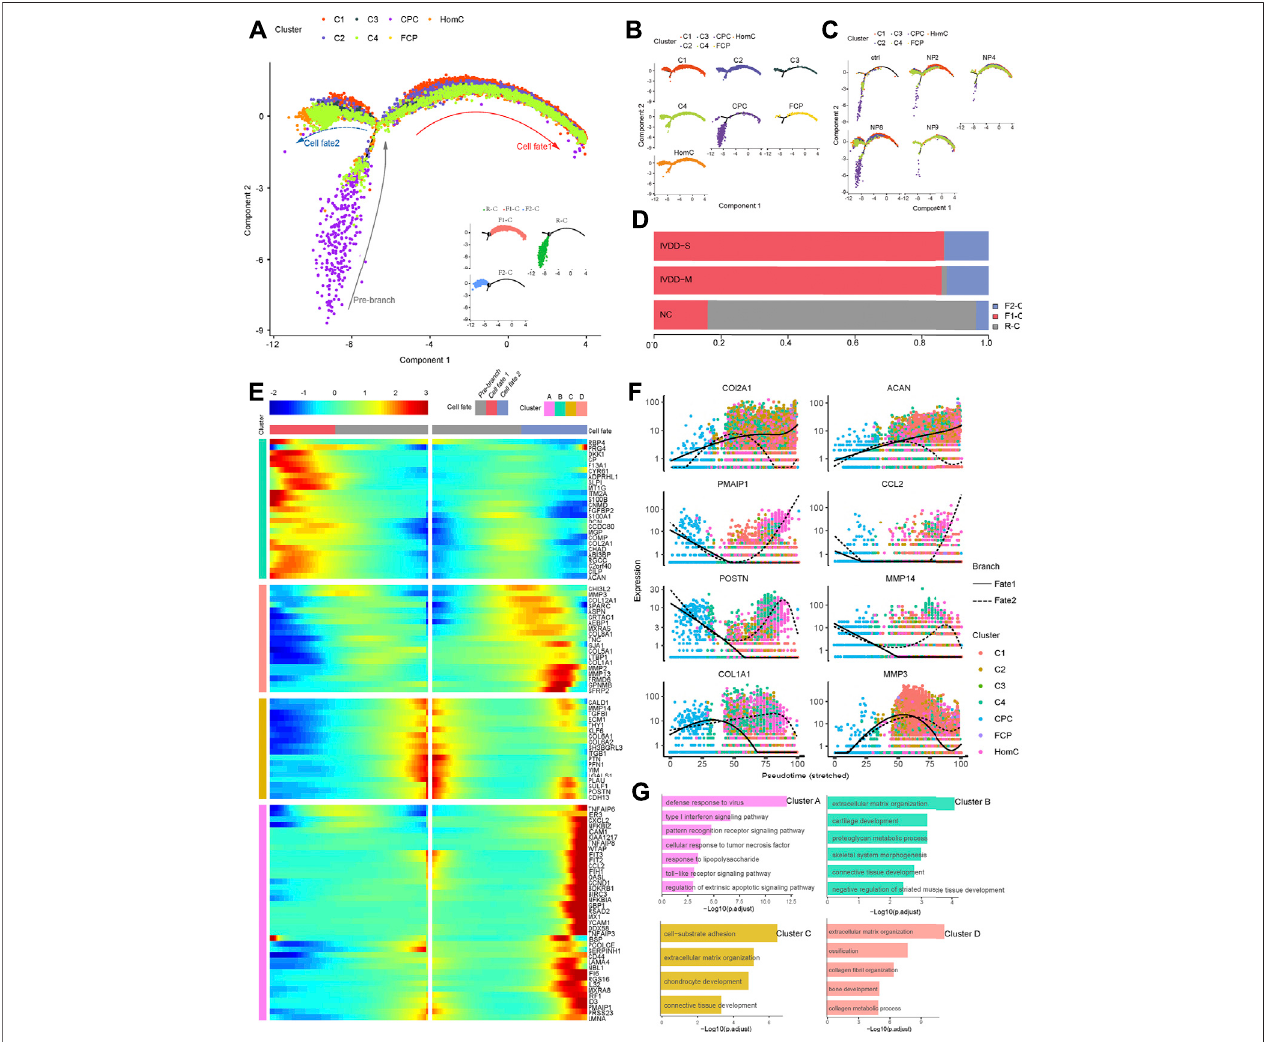
FIGURE 4 | Pseudotime trajectory analysis depicted chondrocyte fate differentiation in IVDD. (A) Monocle two trajectory plot contains three branches and one connecting point showing dynamics of chondrocyte subclusters (except NP10). (B,C) Projection of individual cell types and samples onto the trajectory of (A) . (D) Bar plots represented the proportion of different cell states corresponded to three branches from NC, IVDD-M, and IVDD-S. (E) Heatmap showing the standardized kinetic curvesofthegenesintrajectoryfromroottofate1orfate2. (F) Pseudotimekineticsofspeci fi crepresentativegenesfromtherootofthetrajectorytofate1(solidline) and fate2(dashedline). (G) BarplotsshowingthetopannotatedGOtermsinfourgenessets,whicharehierarchicallyclusteredfrom (E) .CPC,cartilageprogenitorcells; FCP, fi brochondrocyte progenitors; HomC, homeostatic chondrocytes.